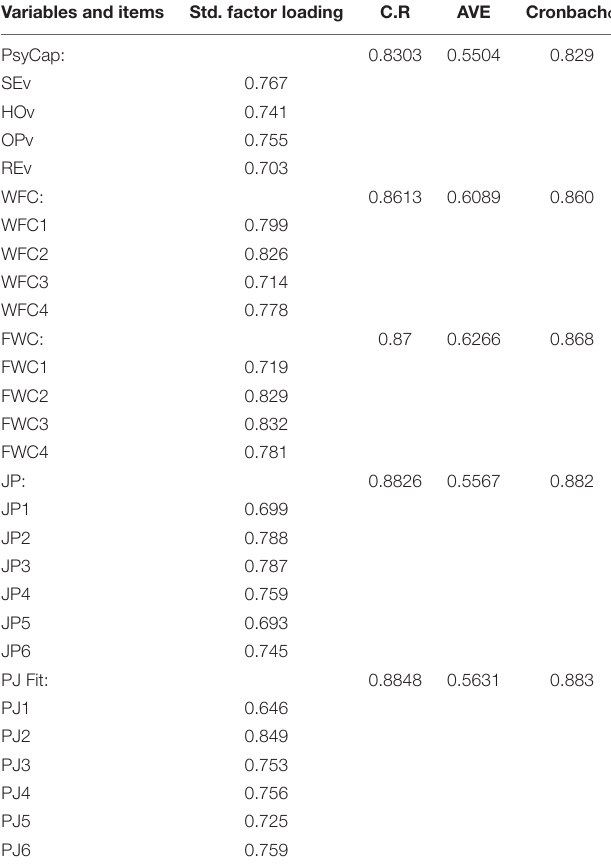
TABLE 2 | Results of reliability and convergent validity of the full measurement model. Variables and items